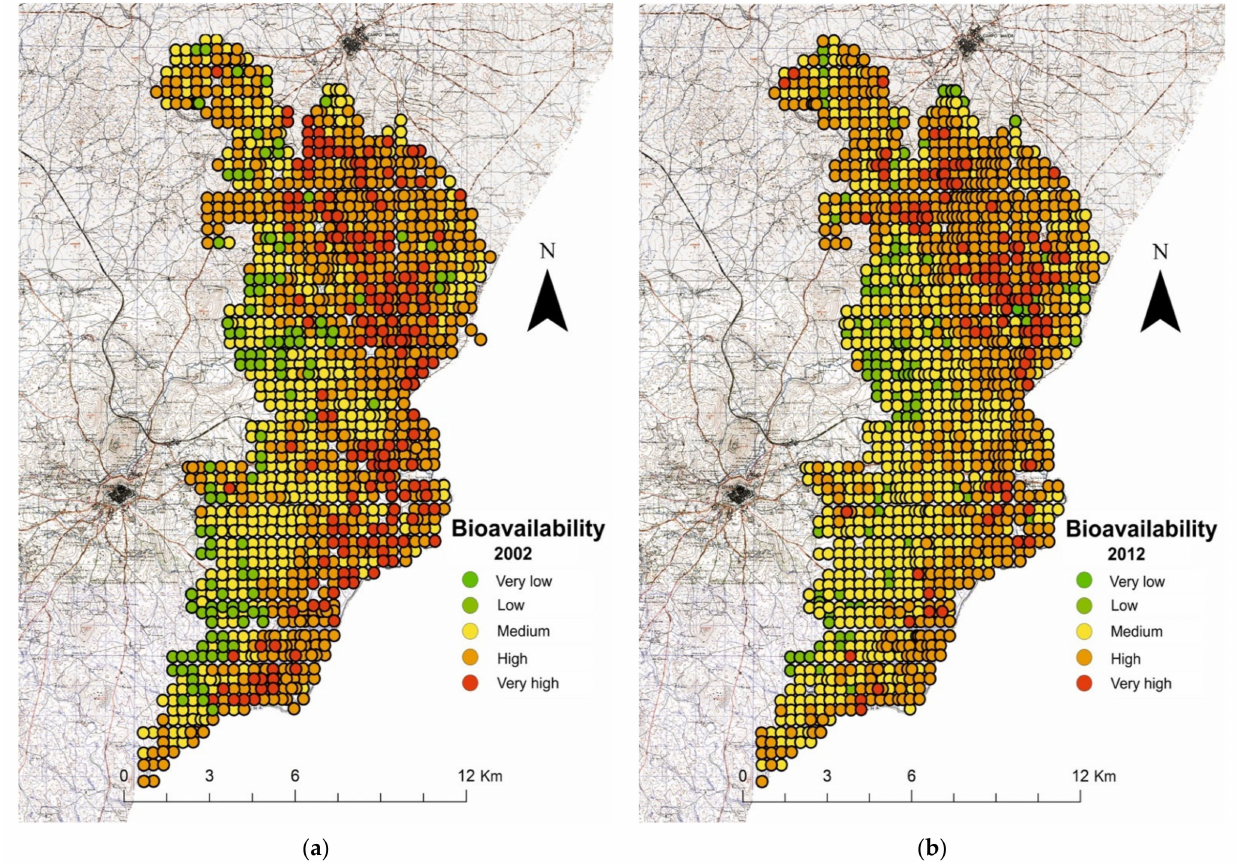
Figure 6. Predictive map for the metal bioavailability in the study area in ( a ) 2002 and ( b )